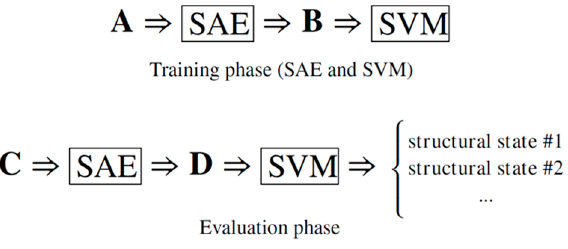
Figure 3. SHM strategy using SAE.